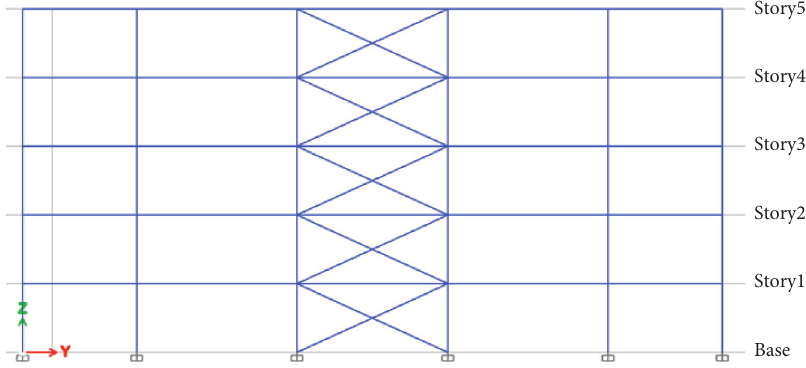
Figure 9: View of the selected two-dimensional frame. Table 6: Sections obtained for different structural members in frames with concentric bracing.